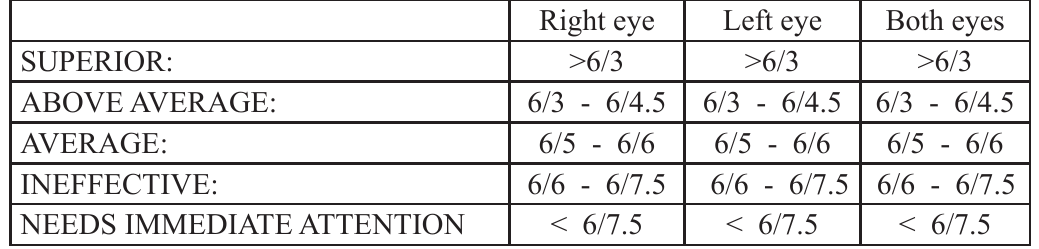
Table 1: The norms for Static Visual Acuity as obtained with the use of a Snellen VA chart and a testing distance of 6 metres.